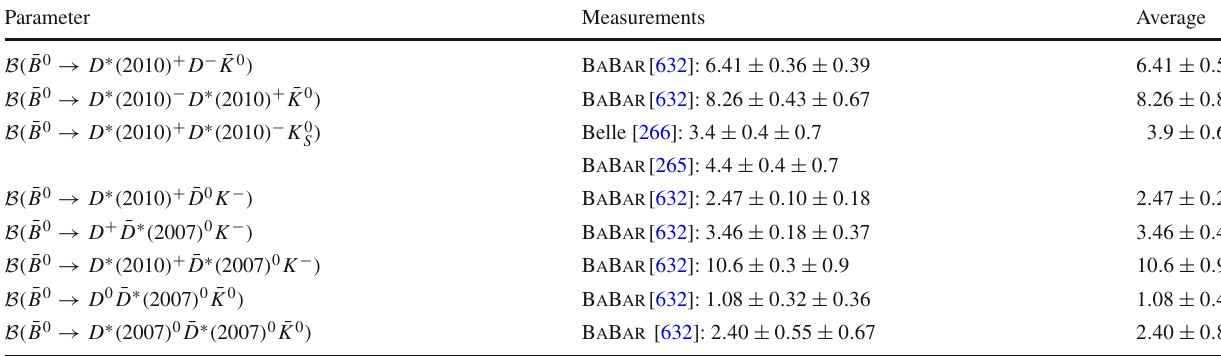
Table 107 Decays to two D mesons and a kaon I [ 10 − 3 ] Parameter